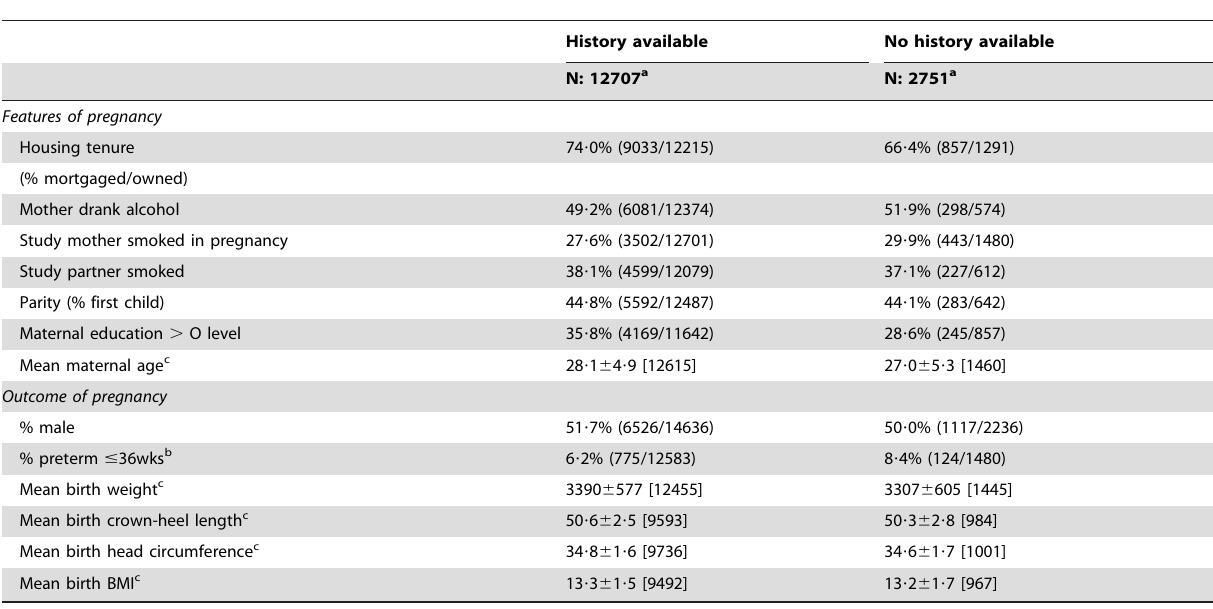
Table 3. Difference between study parents with and without details available of maternal grandmother’s smoking